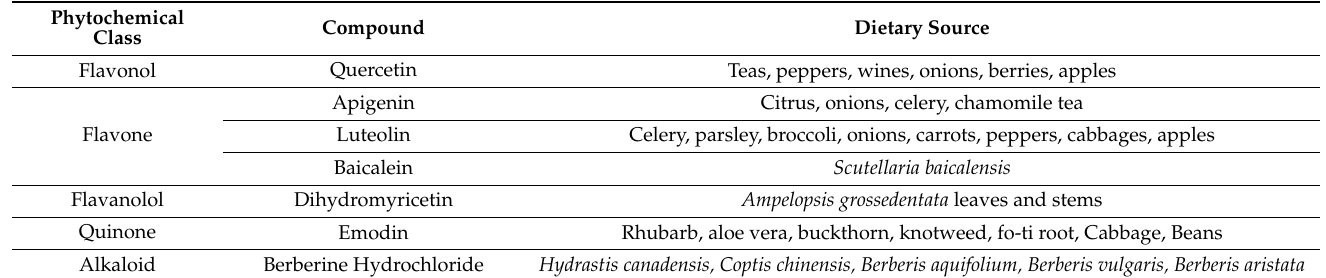
Table 3. Anti-hypertrophic compounds and their dietary